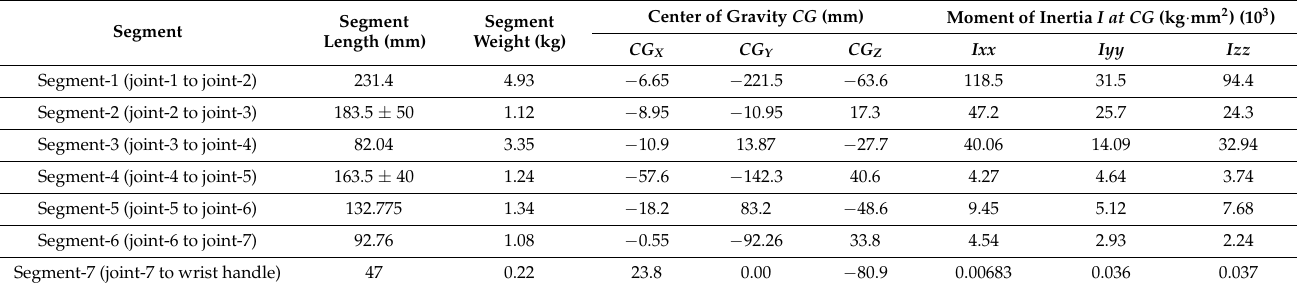
Table 3. Mass inertia properties of the proposed exoskeleton